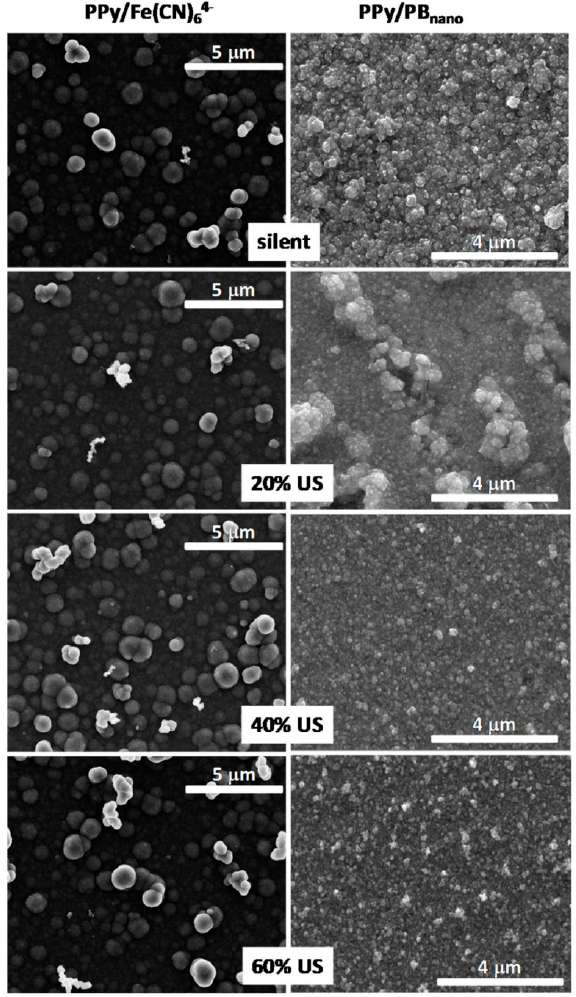
Figure 9. Representative FEG-SEM images taken from ITO electrodes modified by PPy/Fe(CN) 64 − and PPy/PB nano employing different US amplitude. All electrodes were modified by the same PPy deposition charge 160 mC/cm 2 . Reprinted from [37] with permission from Elsevier.